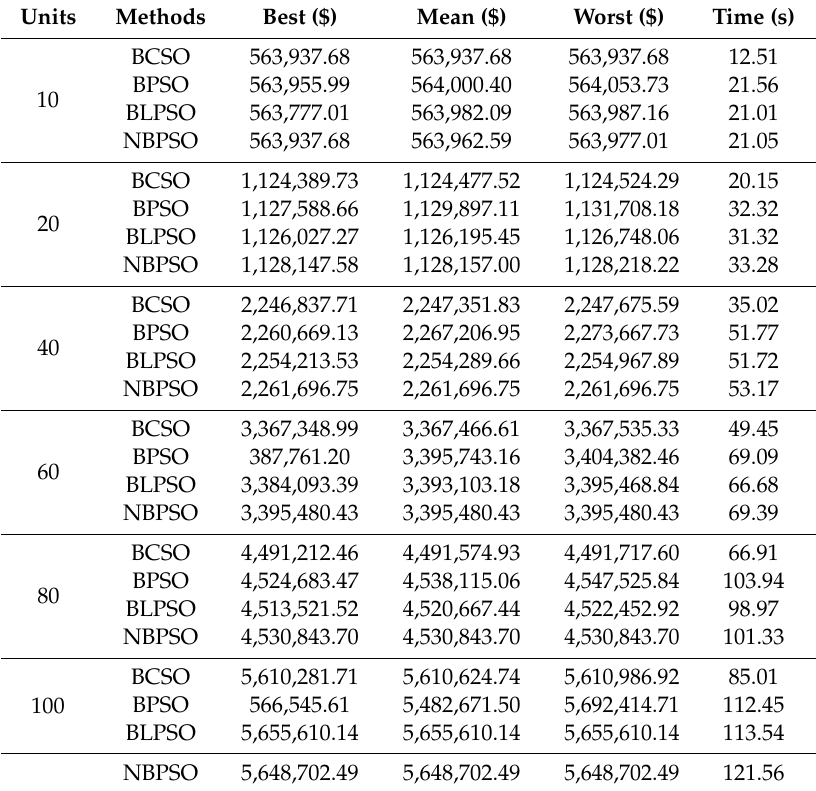
Table 4. Comparisons using di ff erent methods for di ff erent Unit numbers.